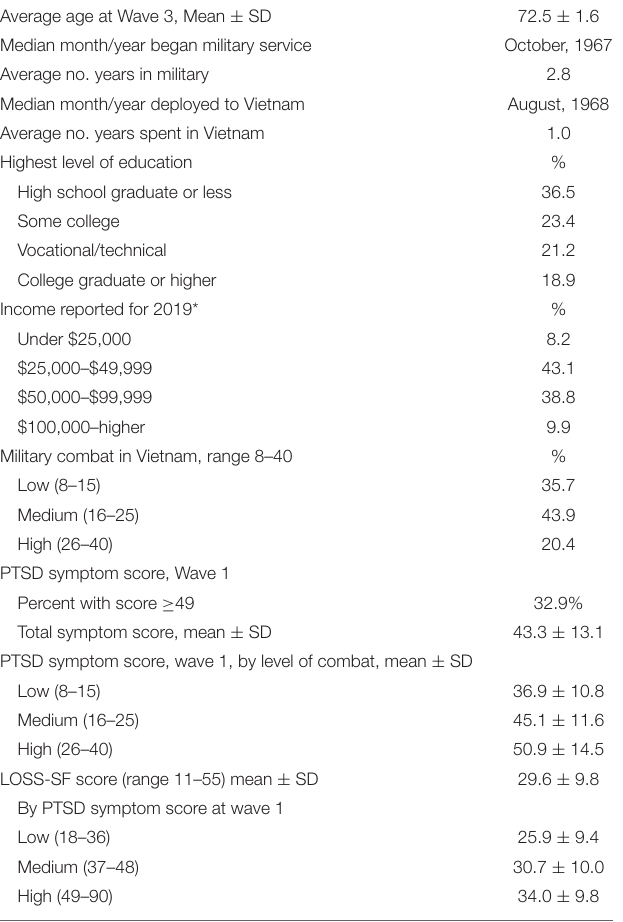
( Table 4 ): 4% practiced social distancing, 16.6% stayed at